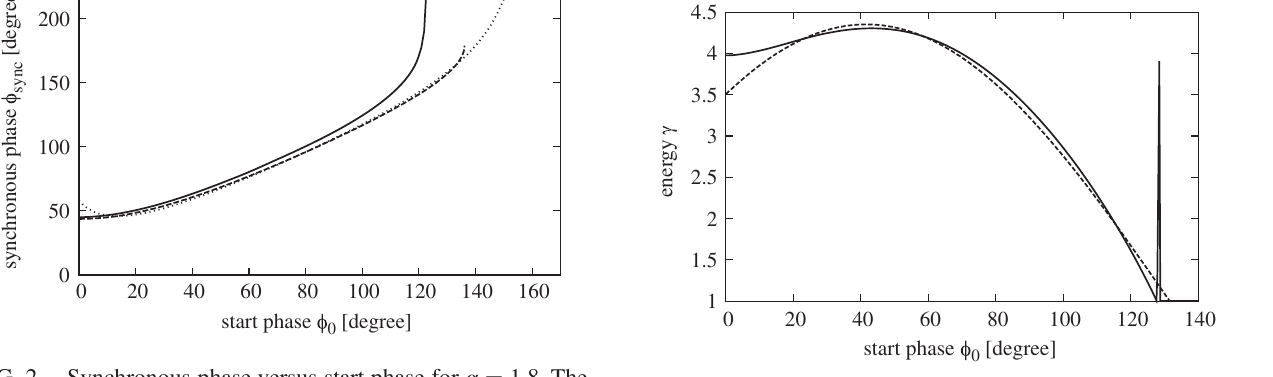
FIG. 4. Energy gain in the half-cell of an rf gun cavity versus start phase for α ¼ 1 . 8 . The solid line shows the result of a numerical integration, while the dashed line corresponds to Eq. (10). The effective phase Eq. (18) has been used. The peak appearing in the numerical result at ≈ 130 ° will be discussed